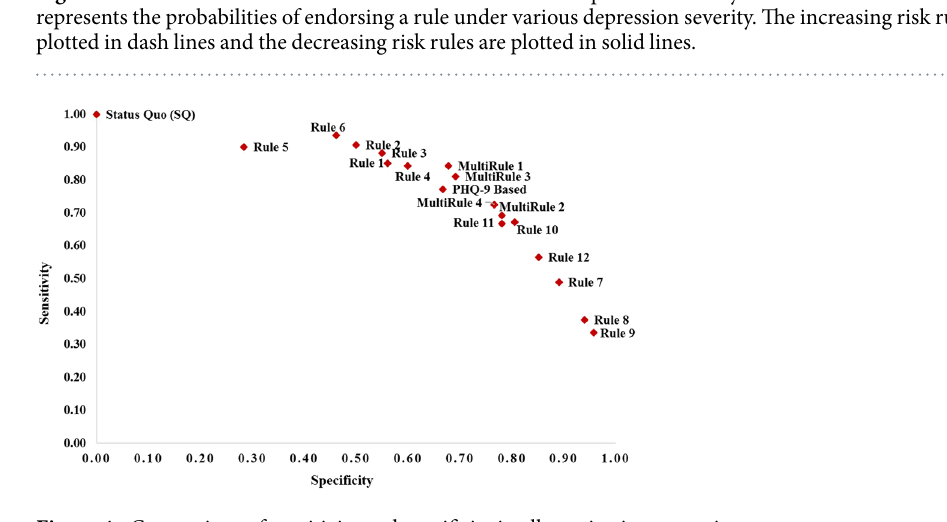
Figure 4. Comparison of sensitivity and specificity in all monitoring